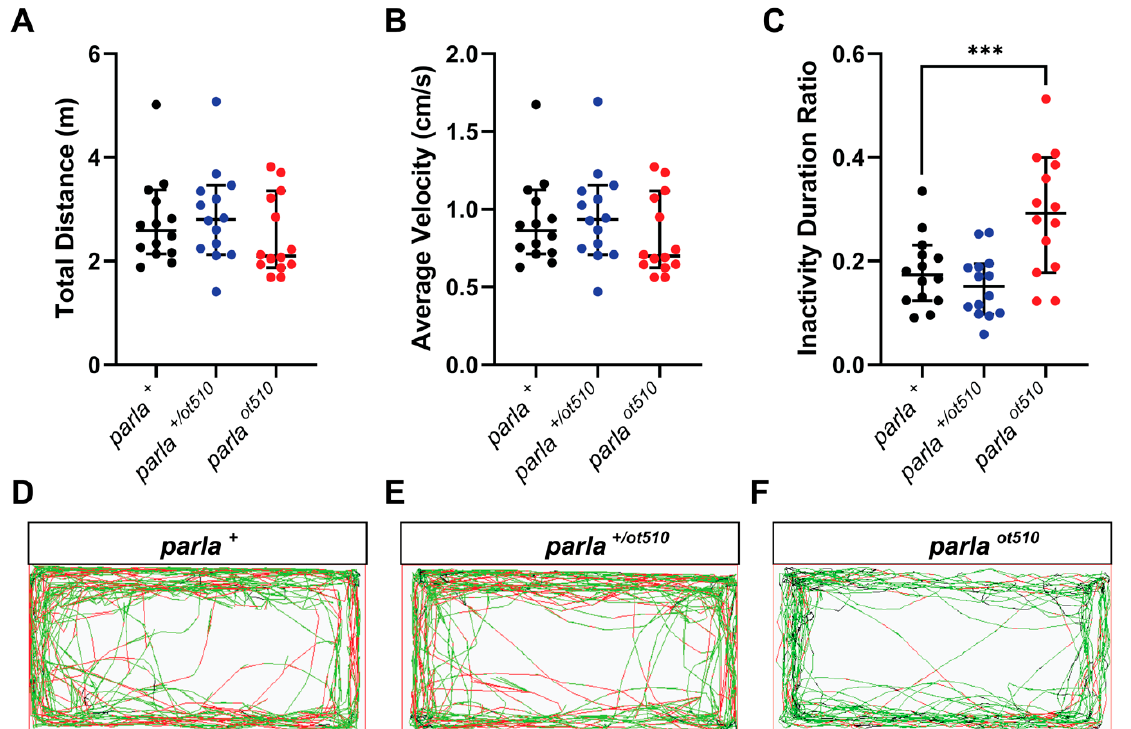
Figure 5. Swimming activity of adult mutant and WT zebrafish. ( A – C ) Impact of parla loss-of-function on total swim distance, average swimming velocity and inactivity periods ( n = 14 adult zebrafish). ( D – F ) Path images of a representative for WT fish ( parla + ), homozygous mutants ( parla ot510 ), and heterozygous mutants ( parla +/ot510 ). Bars represent the Median with 95% CI. *** ( p < 0.001).